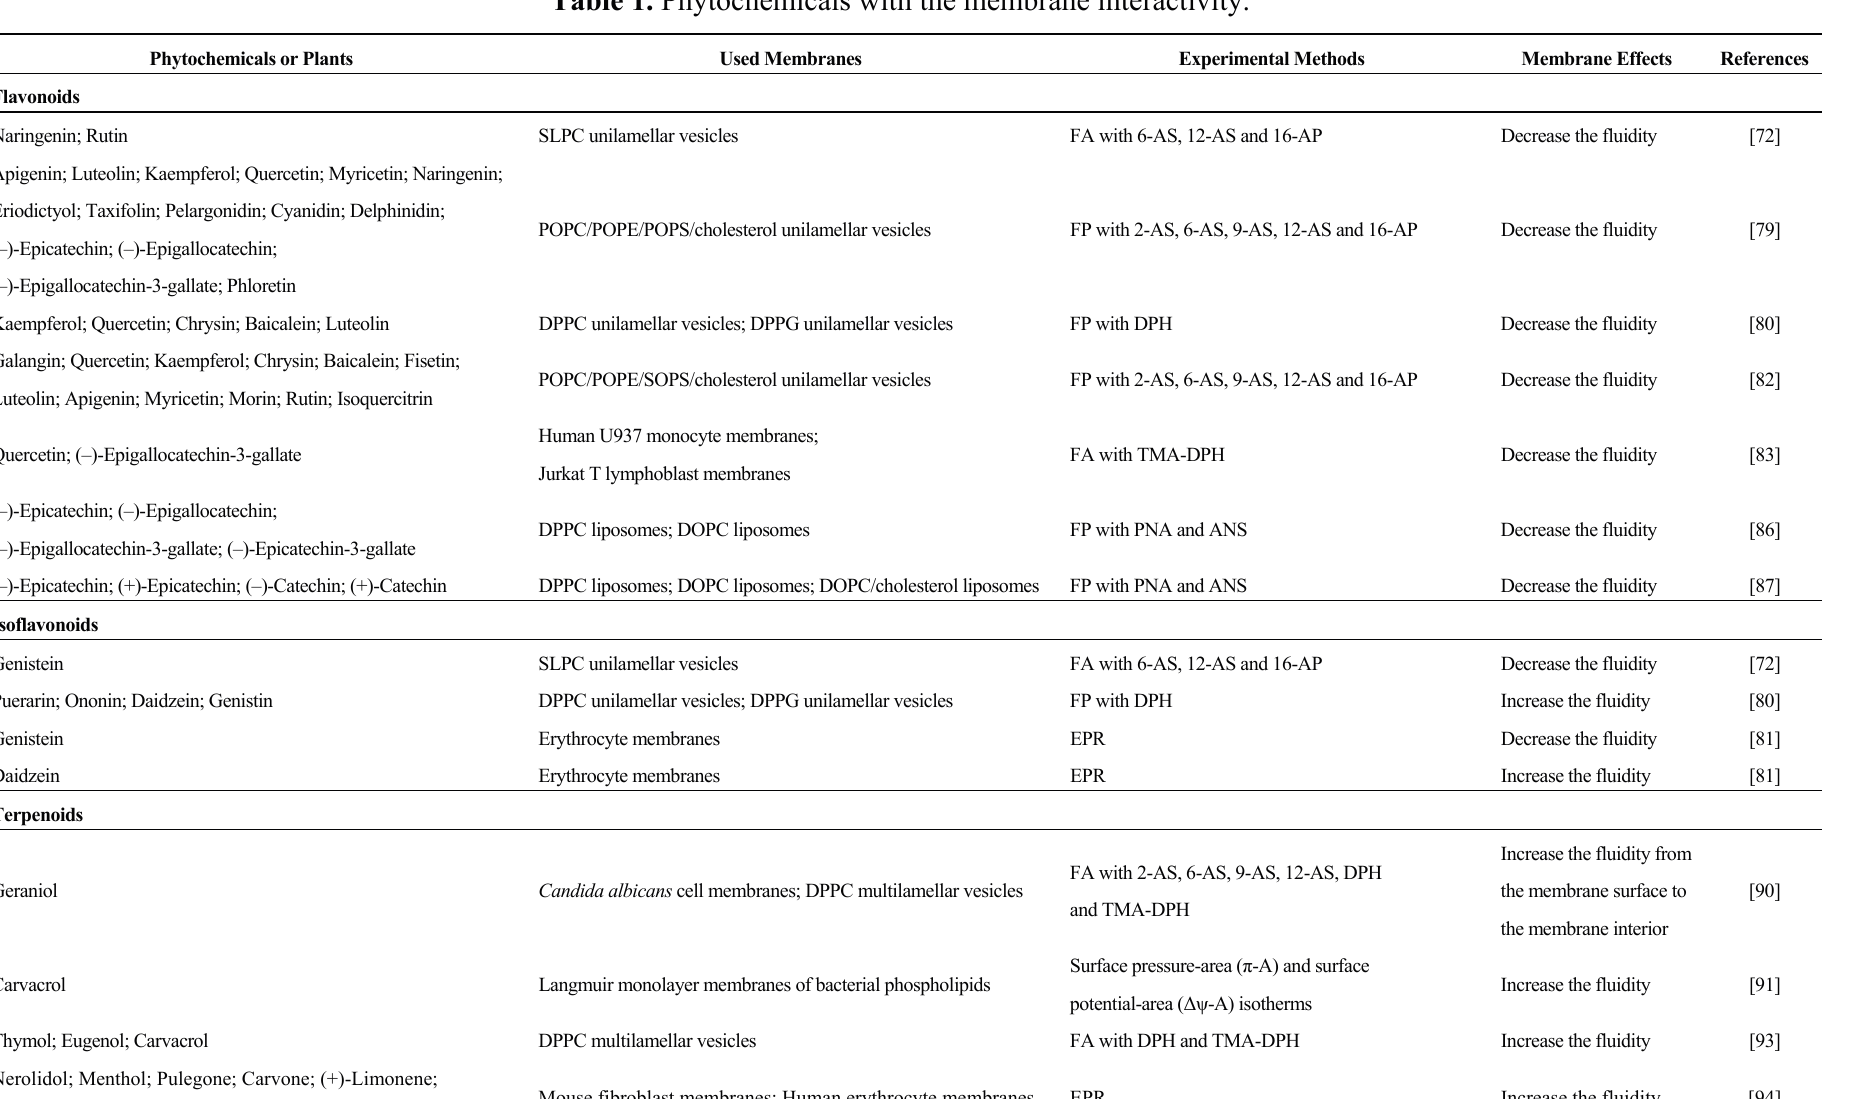
Table 1. Phytochemicals with the membrane